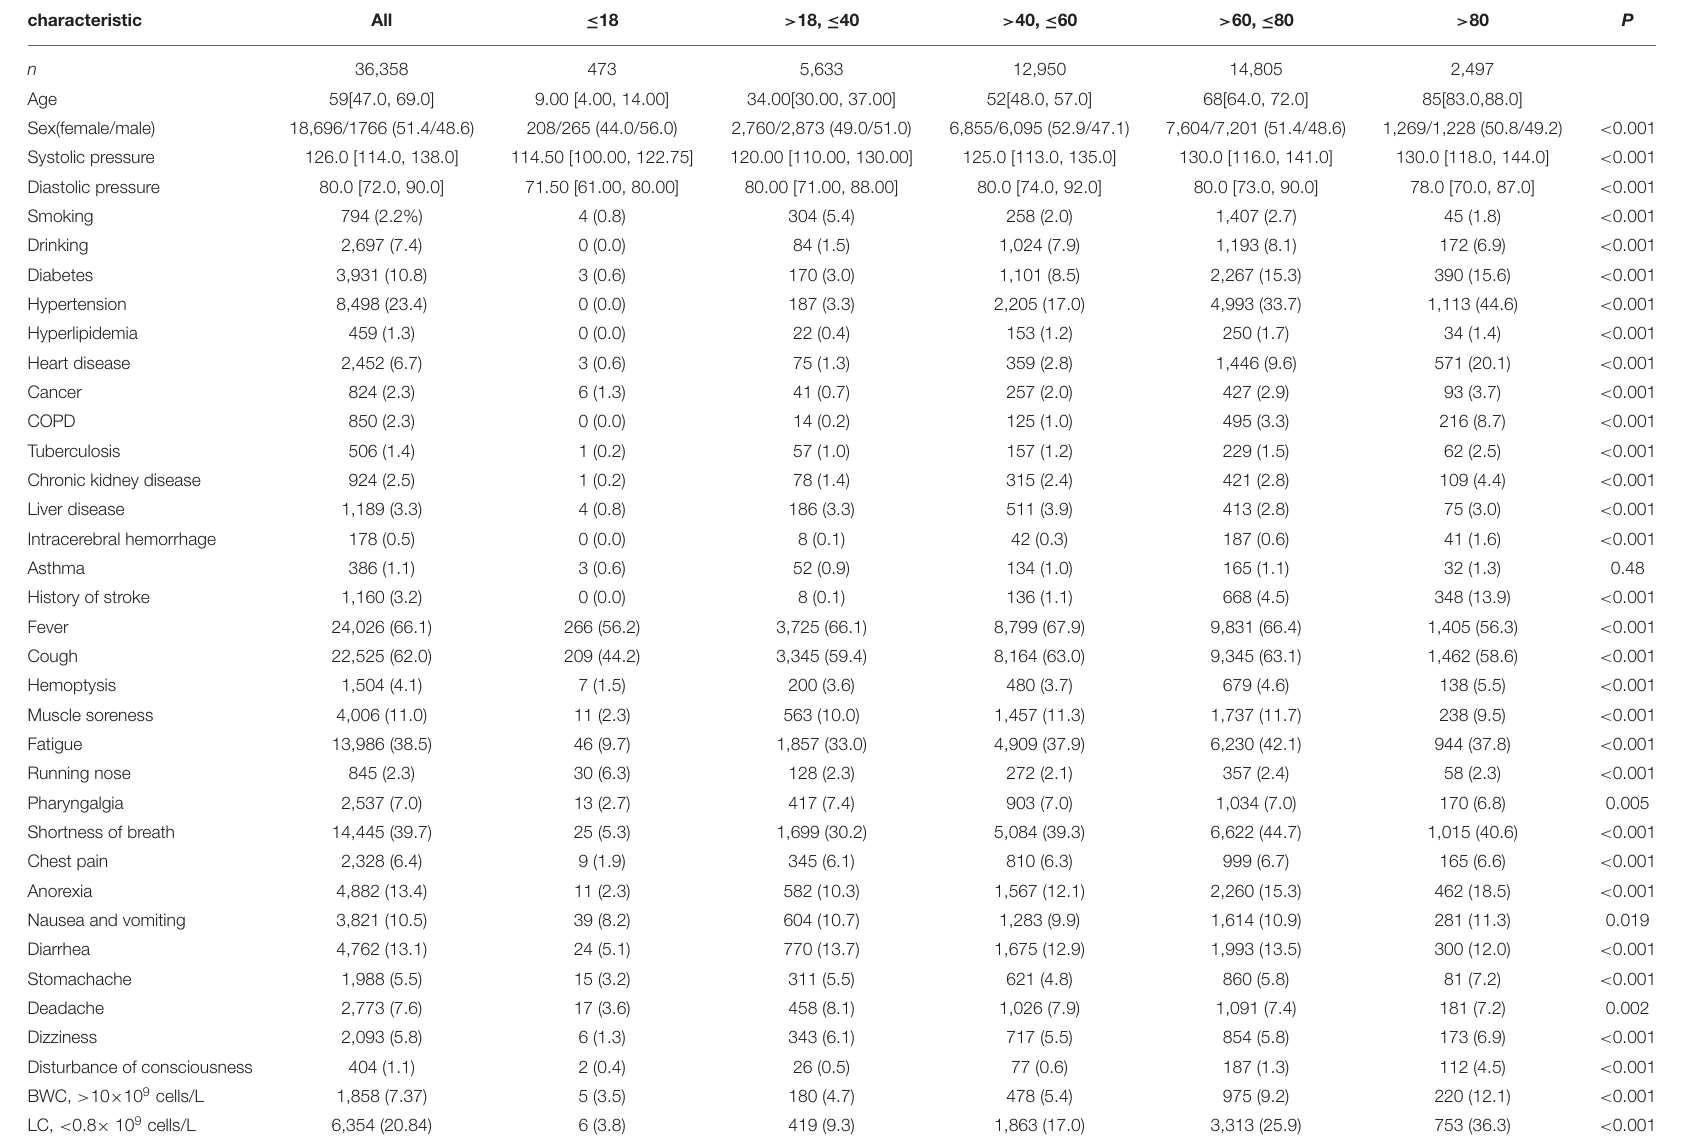
TABLE 1 | Baseline characteristics and outcomes of patients with coronavirus disease 2019 (COVID-19) in different age groups.